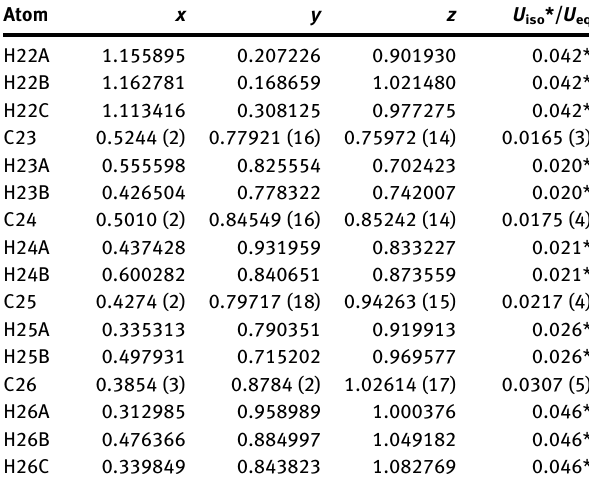
precipitatethatformedwas fi ltered,thenwashed3timeswith cold ethanol to remove unwanted residues. The precipitate